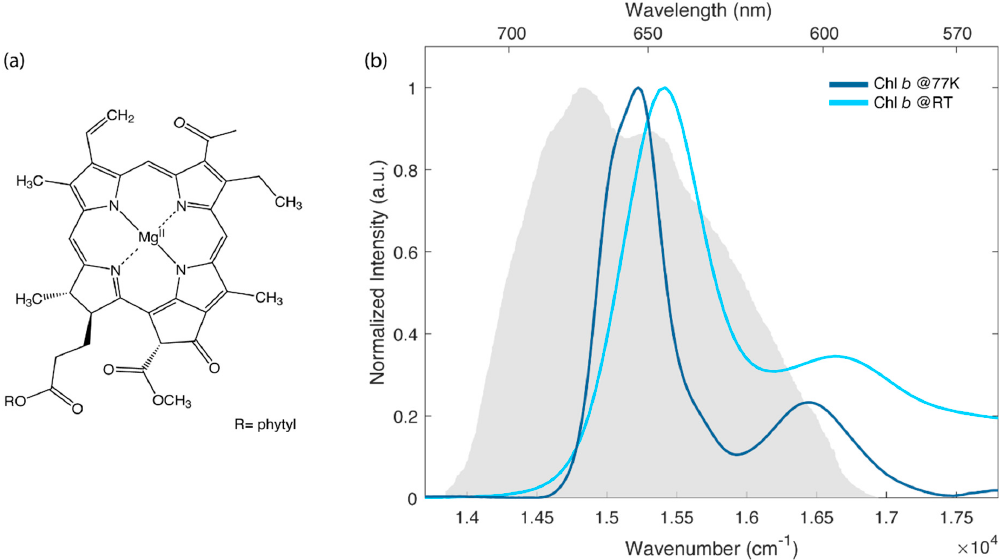
Figure 1. ( a ) Molecular structure of chl b . ( b ) Normalized absorption spectra of chl b in the Q bands region at room temperature (light blue) and at 77 K (dark blue). The solvent is a mixture 4:1 (v:v) of ethanol and methanol. The grey area represents the laser spectrum profile used in the 2D electronic spectroscopy (2DES) experiments.